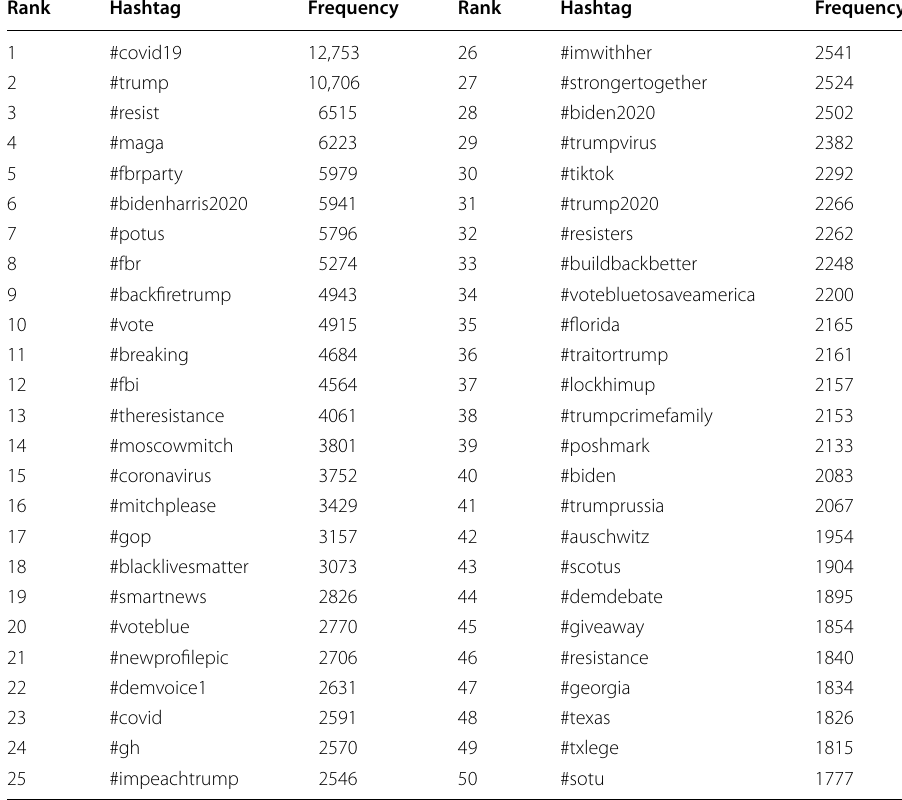
Table 7 Top‑50 popular hashtags from the tweets posted by the users labeled as “conservative” or